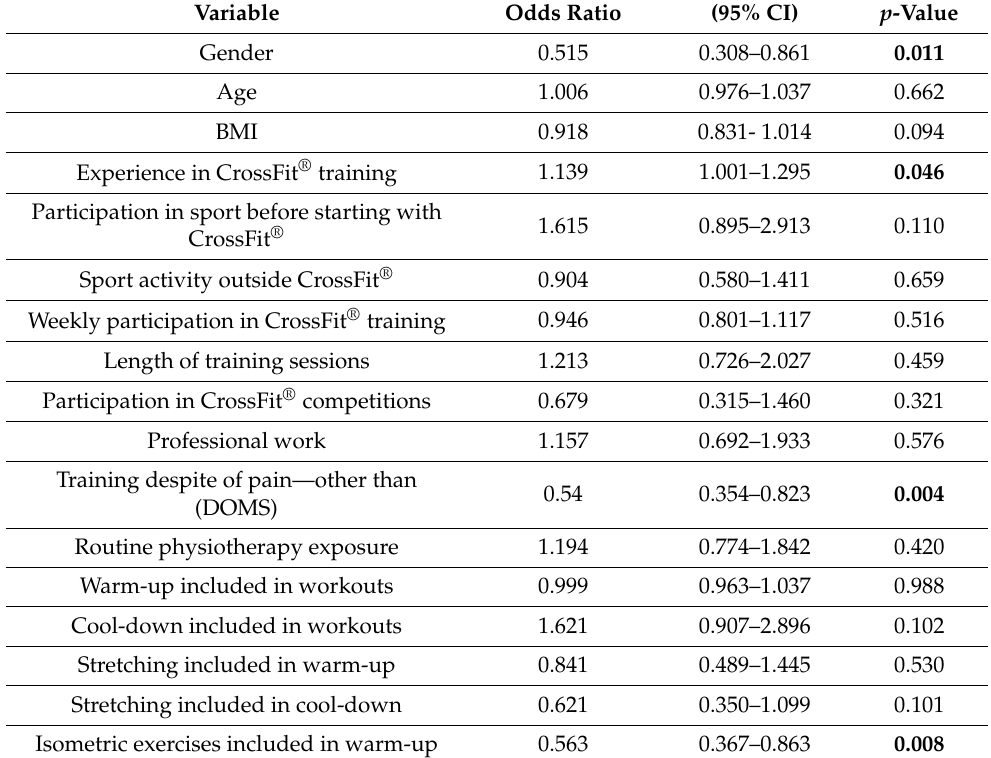
Table 3. Logistic regression analysis of injury risk factors.